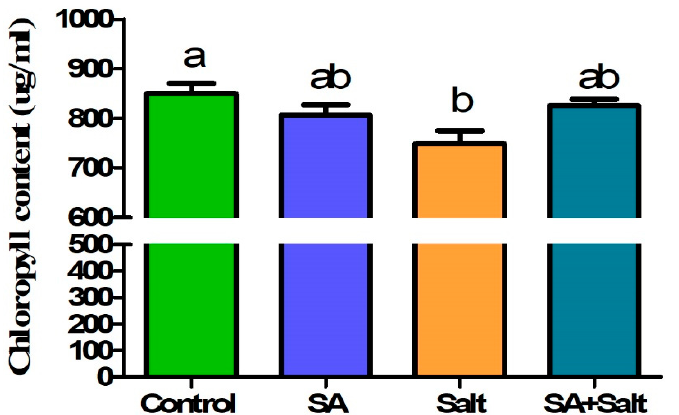
Figure 1. Leaf disk bioassay for selecting the appropriate concentration of salicylic acid for salinity- damaged St. John’s wort. Treatments: control, SA (0.25 mM salicylic acid), salt (150 mM NaCl), SA (0.25 mM salicylic acid) + salt (150 mM NaCl). Each value represents the mean ± SD ( n = 20). Different letters on each bar represent statistically significant differences as evaluated by DMRT and t -test at p ≤ 0.05.